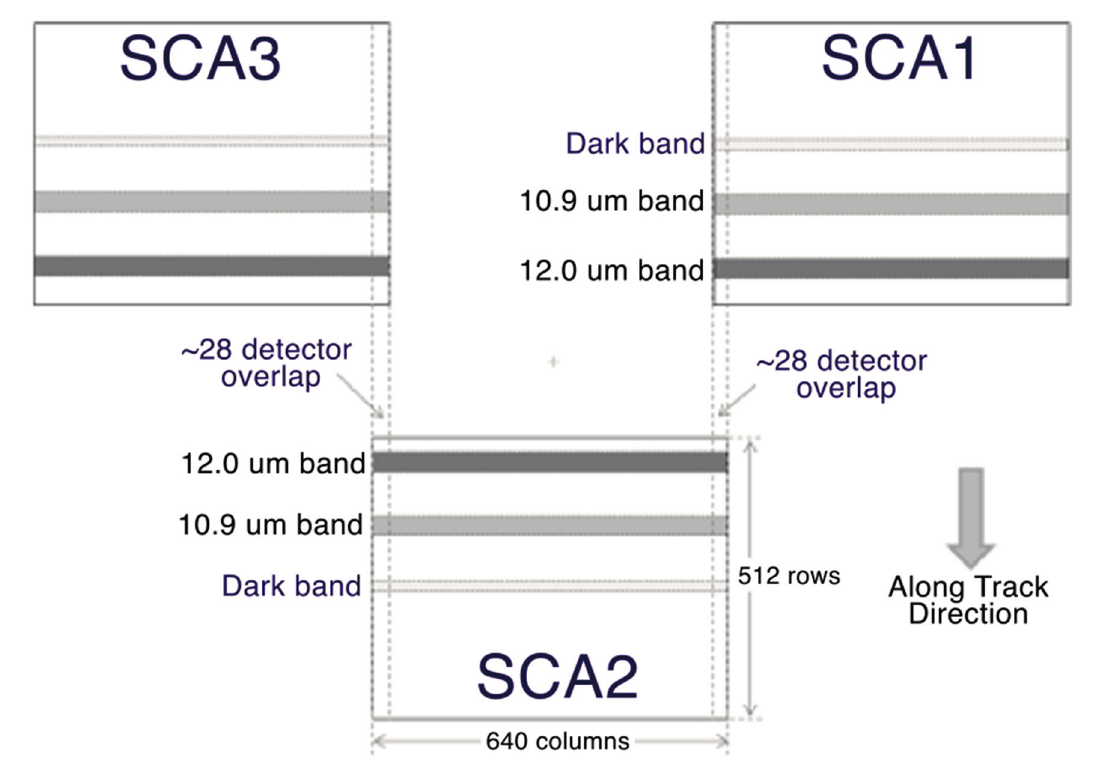
Figure 2. TIRS focal plane diagram. The areas of the three SCAs covered by the spectral filters are indicated, along with the region on each SCA used to measure the dark